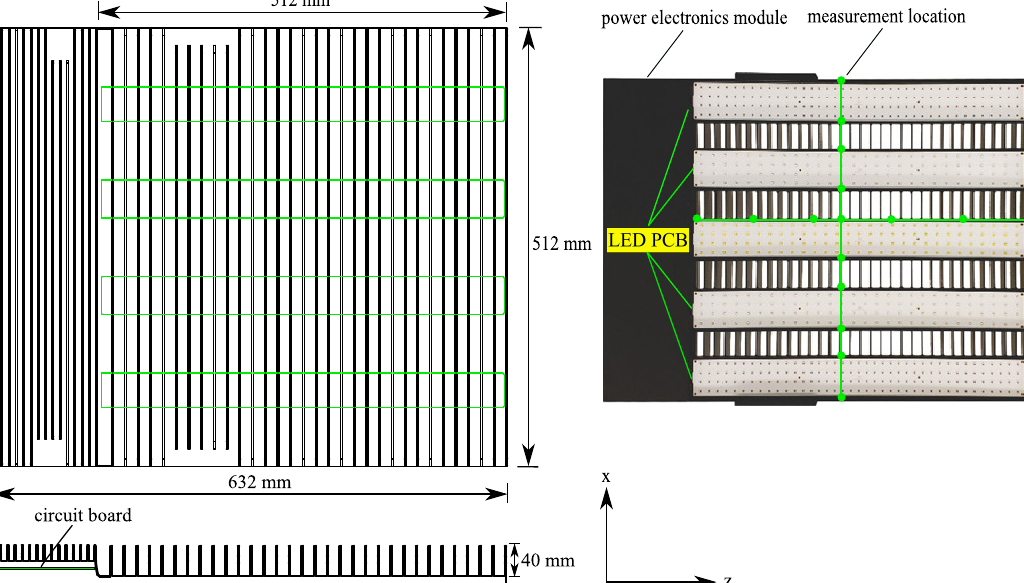
Figure 10. New heat sink enclosure ( left ) for the prototype LED grow light ( right ). The green circles represent the locations of temperature